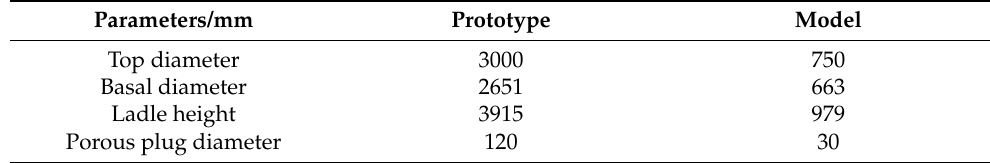
Table 1. Dimensions of prototype and model.